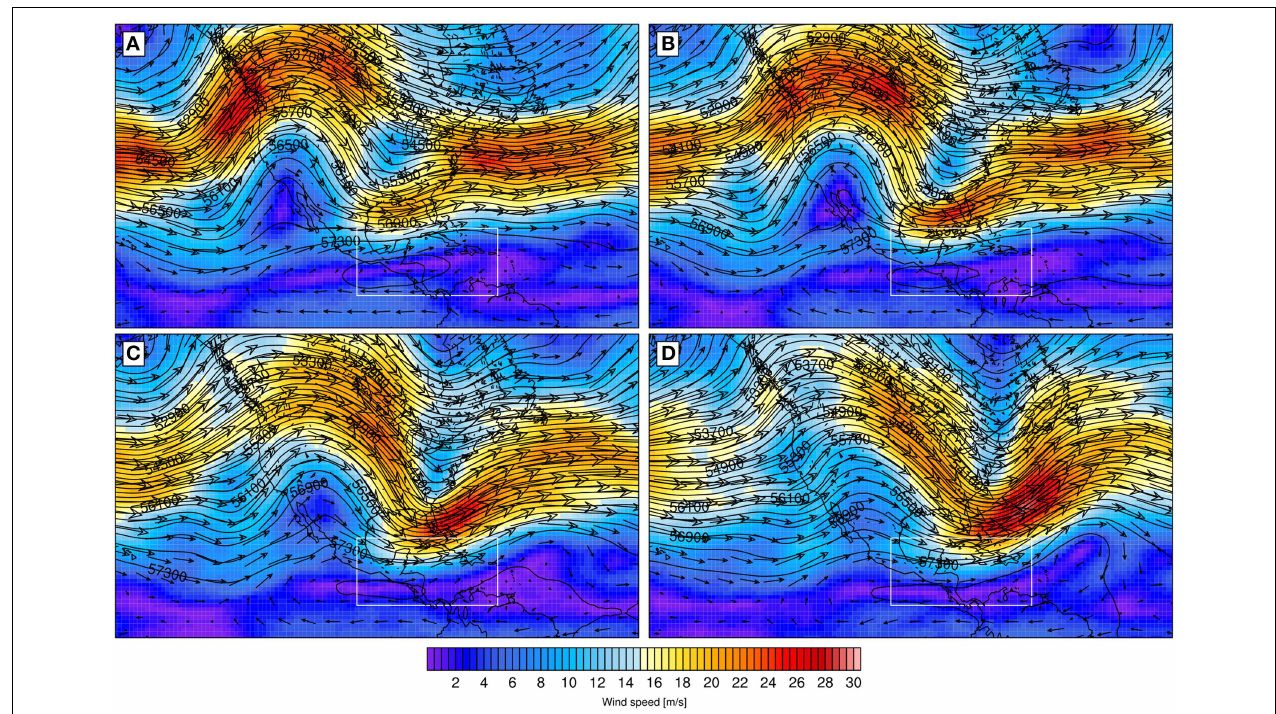
FIGURE 13 | Same as Figure 12 for 500hPa fields. (A) shows fields typical for the day previous to the onset. (B–D) show fields typical of days 1, 2 and 3